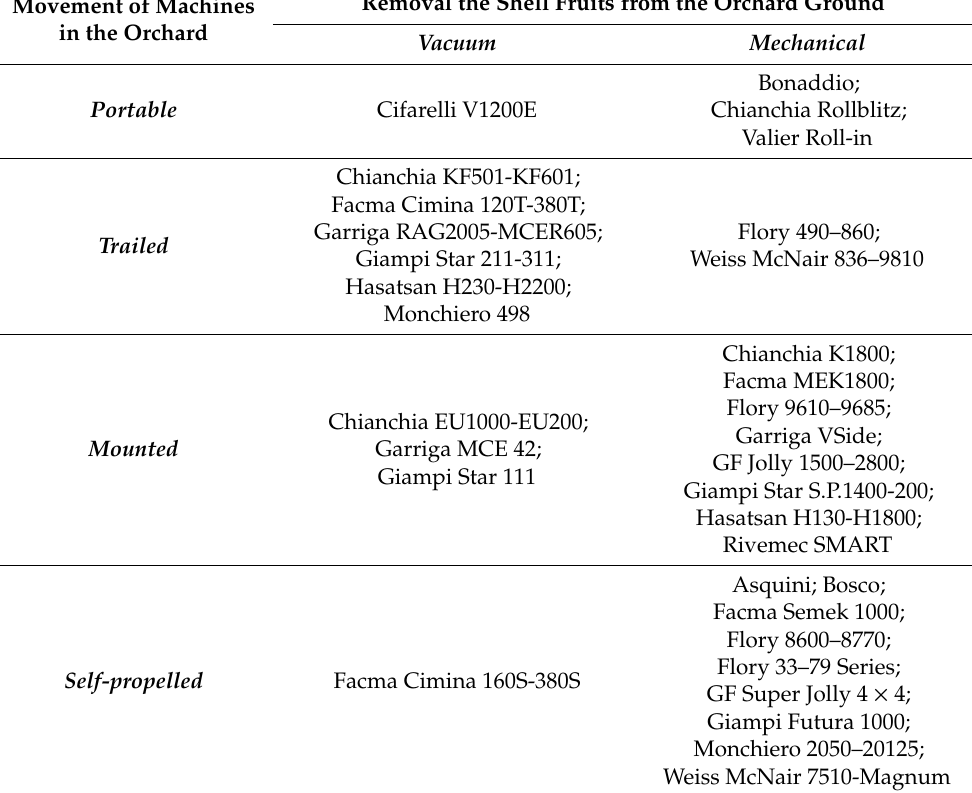
Table 3. Overview of the models belonging to each category, according to the scientific literature review and Internet